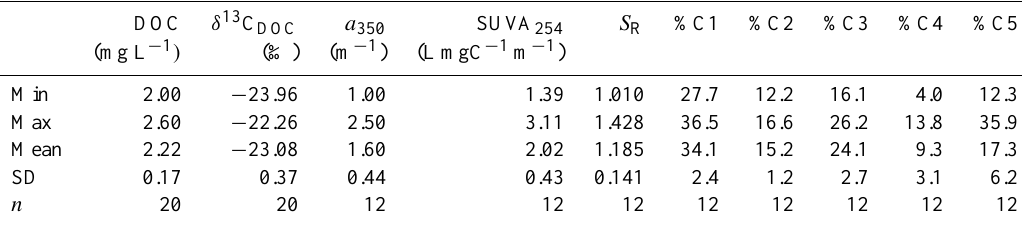
Table 2. Temporal variations in DOM properties measured at the outlet of the Kariba Reservoir during an almost 2-year monthly sampling (from February 2012 to November